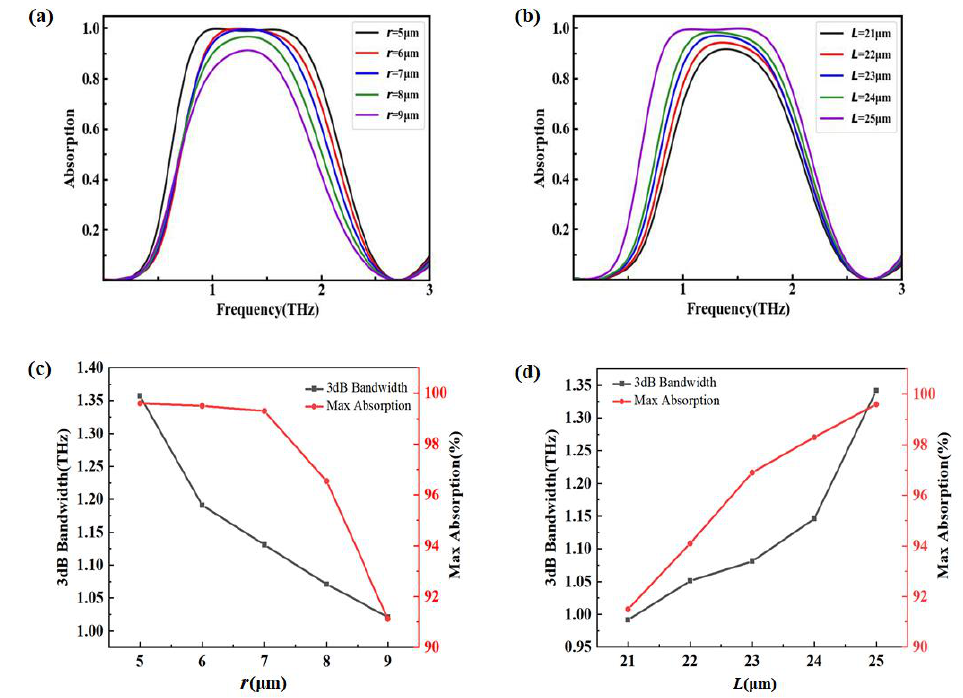
Figure 6. Absorption spectra with different geometrical parameters. ( a ) Different r ; ( b ) different L ; ( c , d ) 3 dB bandwidth and the maximum absorption with different r and L , respectively.